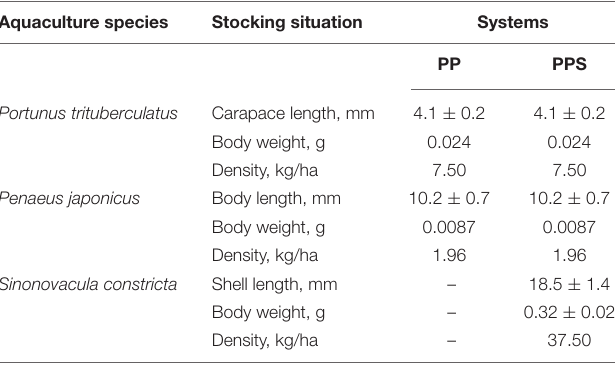
TABLE 1 | Stocking density of Portunus trituberculatus , Penaeus japonicus , and Sinonovacula constricta in two integrated pond aquaculture ecosystems. Aquaculture